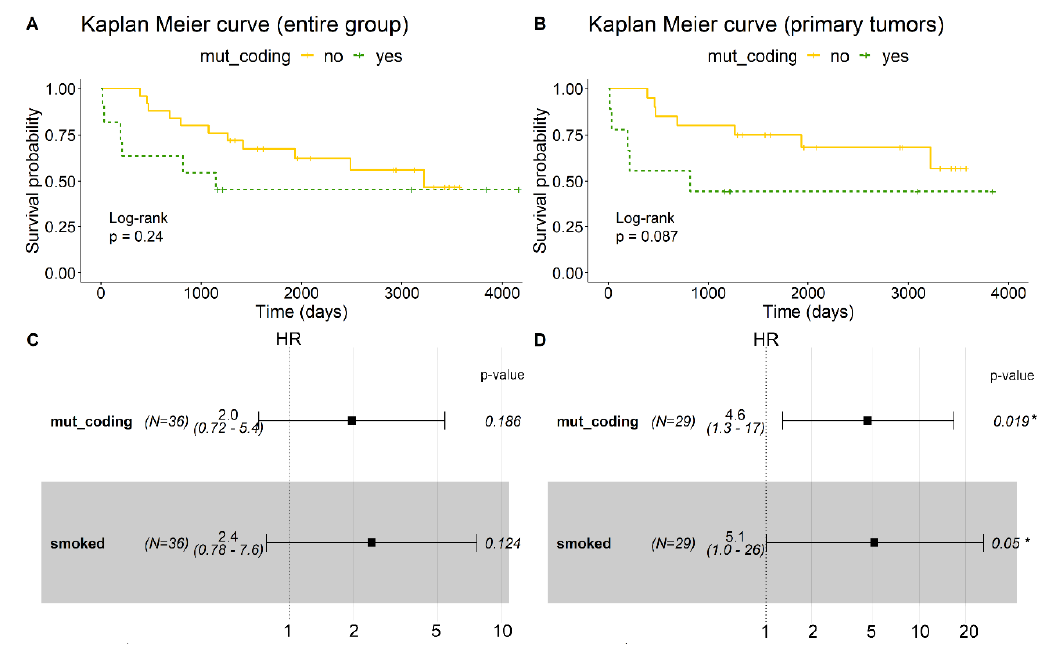
Figure 5. Kaplan–Meier curve for the entire patient group, n = 36 ( A ) and only in patients with primary tumors, n = 29 ( B ). Patients who harbored at least one mutation in the mtDNA protein-coding region (green dashed line) had poorer survival rates than patients who did not harbor mutations (yellow straight line). Forest plots of cox proportional-hazard models for mut_coding adjusted for smoking status are shown as: ( C ) for the entire group (HR = 2.0 (95%CI = 0.72–5.4), p = 0.186) and ( D ) for primary tumors (HR = 4.6 (95%CI = 1.3–17), p = 0.019). Mut_coding = ∆ HF% > 20 mutations in mtDNA protein-coding region. * p -value ≤0.05